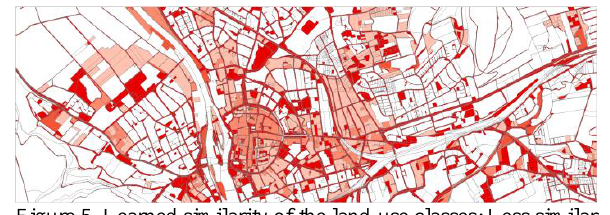
Figure 5. Learned similarity of the land-use classes: Less similar objects are displayed in darker colour.